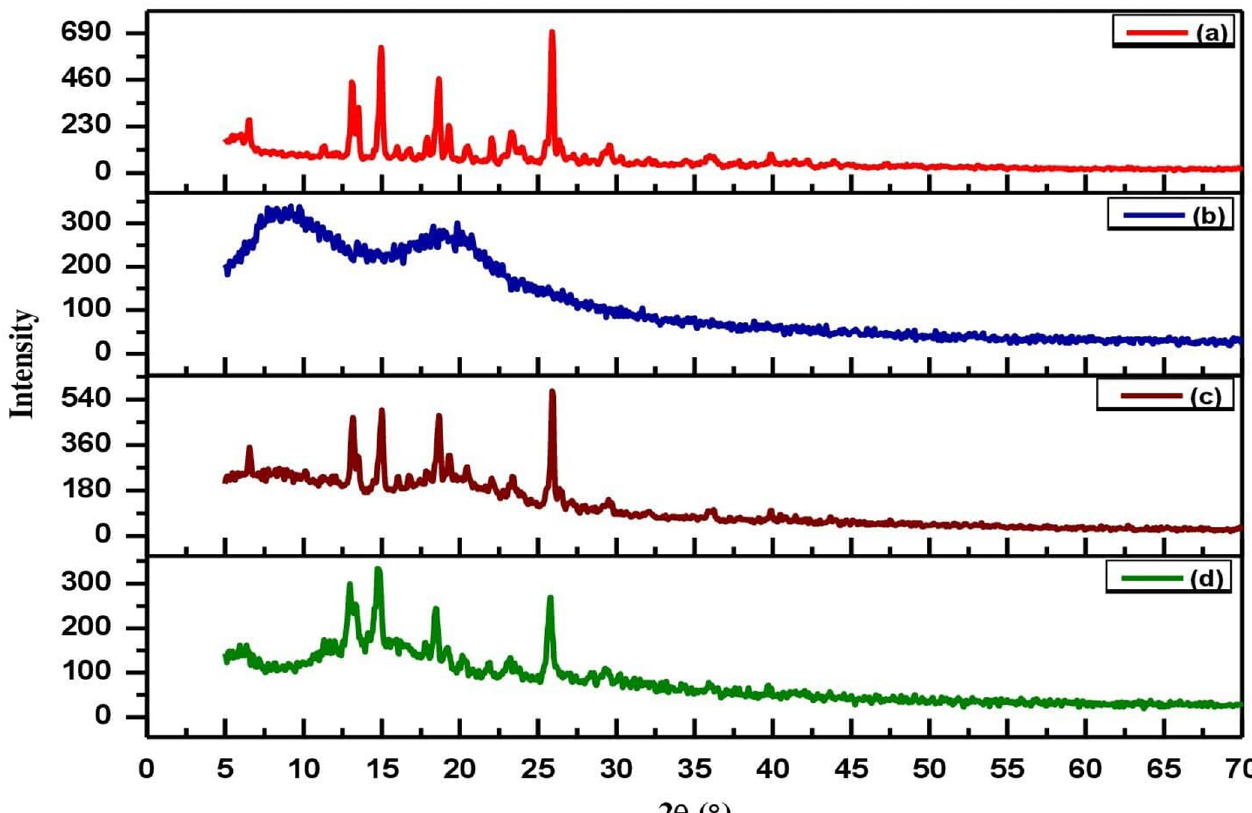
Fig 7. XRD pattern of MLX (a), HPMC (b), physical mixture of MLX & HPMC (c), and optimized formulation (F0), (d).